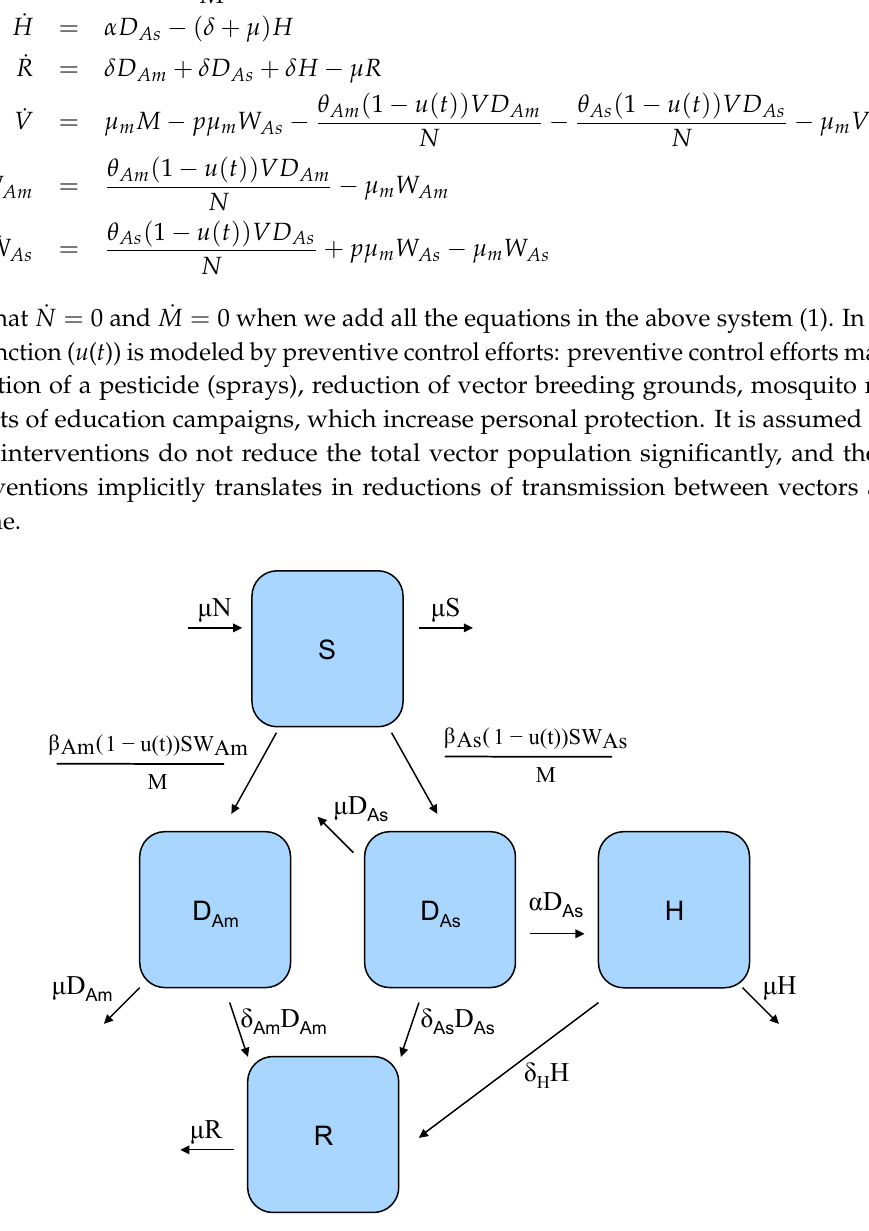
Figure 1. Host model flow diagram: S is the class of susceptible individuals who can become infectious with either DENV-2 American genotype, D Am , or DENV-2 Asian genotype D As via infectious female mosquitoes W carrying the corresponding strain. In this model, only individuals infected with the Asian genotype can progress to DHF, H , and all infected individuals can recover, R . Note that the control function ( 1 − u ( t ) ) is modeled as the reduction efforts in the transmission rate from S either to D Am , or D As